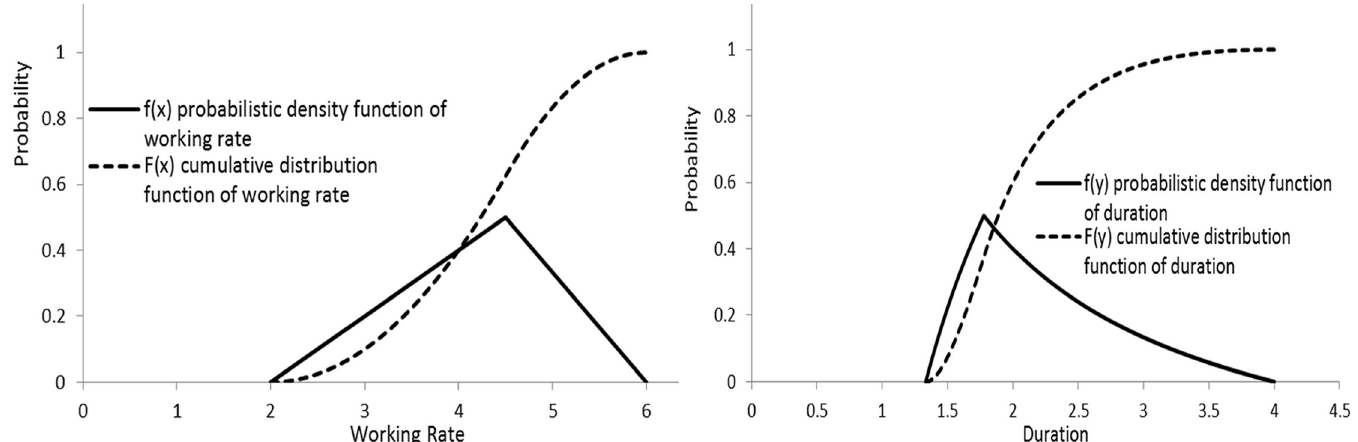
Fig 5. Examples of the probabilistic density and cumulative distribution functions of working rate ( f(x) and F(x) ) and duration ( f(y) and F(y) ).